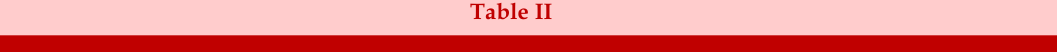
when compared with standard drug tetracycline at the used concentration. The diameters of inhibition zones were found to be higher than Gram-negative bacteria (Table II). The DMSO, as a negative control had no inhibitory effect at the used concentration.